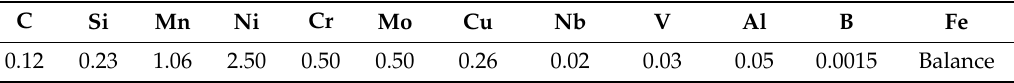
Table 1. Heat analysis of chemical composition of the experimental steel, in wt. %. C Si Mn Ni Cr Mo Cu Nb V Al B Fe 0.12 0.23